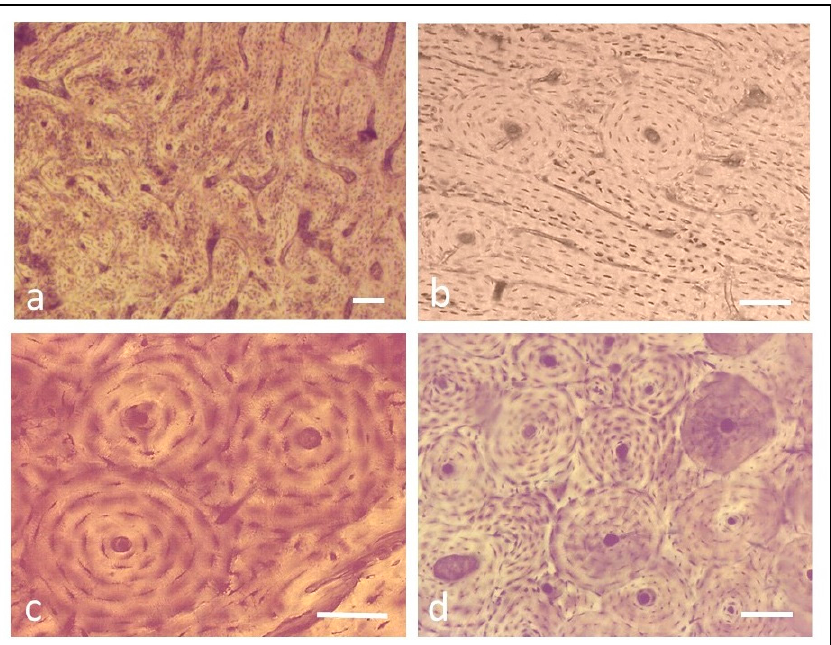
Figure 1. The main types of bone tissue present in mammals. ( a ) Plexiform tissue ( Sus scrofa ); ( b ) irregular Haversian tissue with few osteons isolated and far from each other ( Ovis aries ); ( c ) dense Haversian tissue with an islet of three osteons ( Bos taurus ); ( d ) dense Haversian tissue with many osteons crammed ( Equus caballus ). Bar = 40 µm.